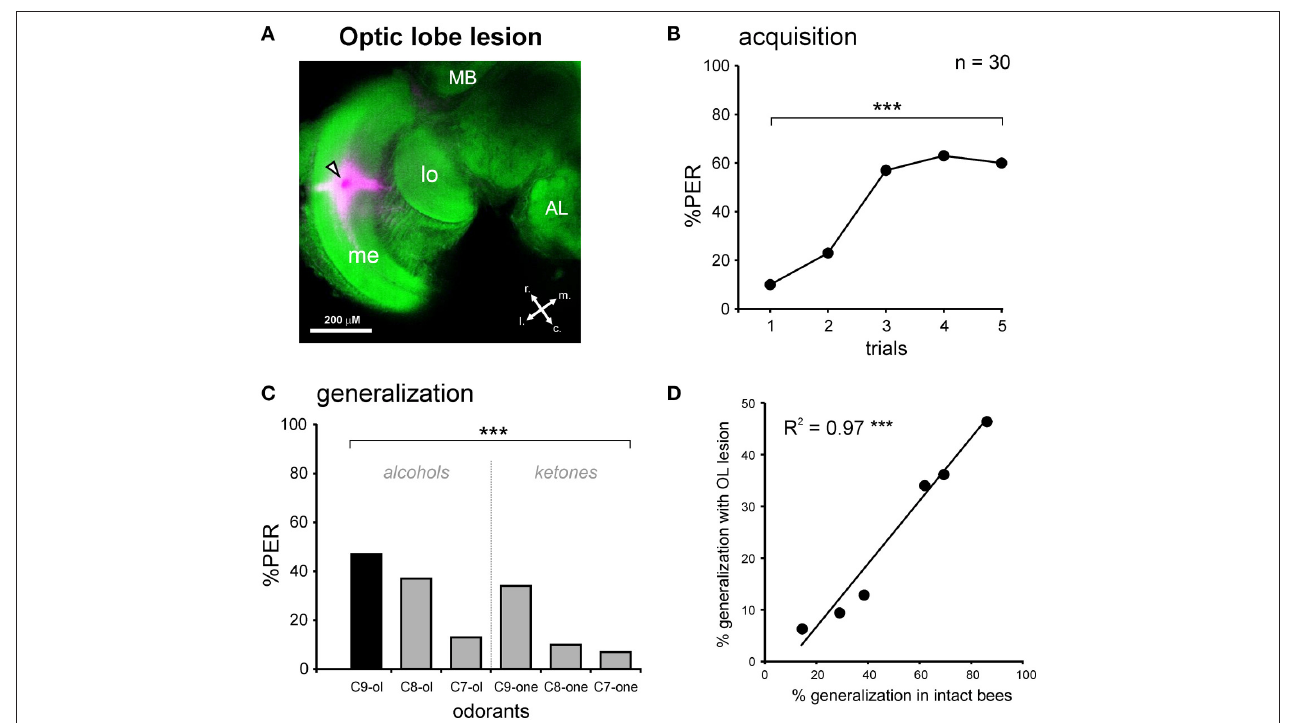
FIGURE 4 | PER conditioning and generalization tests after an optic lobe lesion. (A) Staining during the OL lesion using tetramethylrhodamine and counter-staining with Alexa488 coupled to phalloidin. Abbreviations: MB, mushroom body; me, medulla; lo, lobula; r, rostral; c, caudal; l, lateral; m, medial. The black and white arrowhead points to the lesion site. (B) PER conditioning in bees with an OL lesion. OL-lesioned bees manage to associate the odor CS (1-nonanol, C9-ol) with the sucrose reward (US), as shown by the increase in the PER percentage along trials ( n = 30 ; *** p < 0.001 , Cochran’s Q test). (C) Generalization tests after PER conditioning, using five new odorants differing from the CS by their chain length and/or by their functional group. Bees with an OL lesion respond differentially to the tested odorants ( *** p < 0.001 , Cochran’s Q test). (D) Highly significant correlation between the responses of bees with an OL lesion and the responses of intact bees, during generalization tests ( *** p < 0.001 , R 2 = 0.97